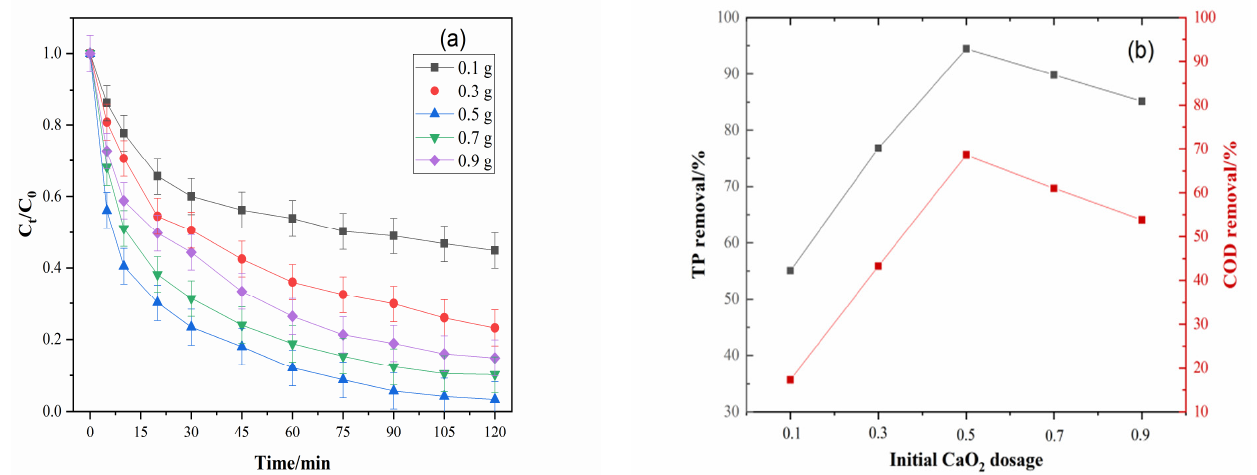
Figure 9. ( a ) Effect of initial CaO 2 dosage on glyphosate removal; ( b ) Effect of initial CaO 2 dosage on TP and COD removal (the molar ratio of Ca 2+ :Fe 2 + = 6, 100 mL 50 ppm glyphosate solution, 150 rpm, pH = 3.0, RT = 25 °C, contact time = 120 min).